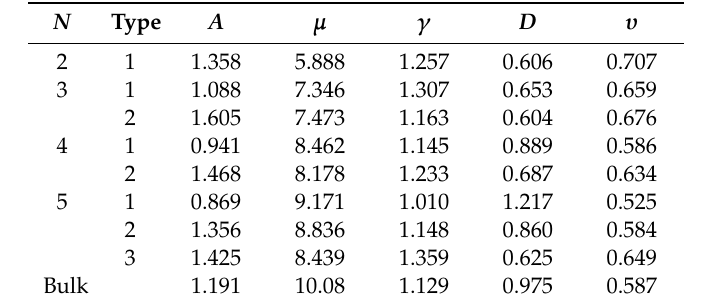
Table 4. Critical parameters of the asymptotic formulas (Equations (1) and (2)) as obtained from non-linear fits on the SAW data presented in Figures 7 and 10 for the confined FCC lattice. Also shown for comparison are the results for the bulk (unrestricted)